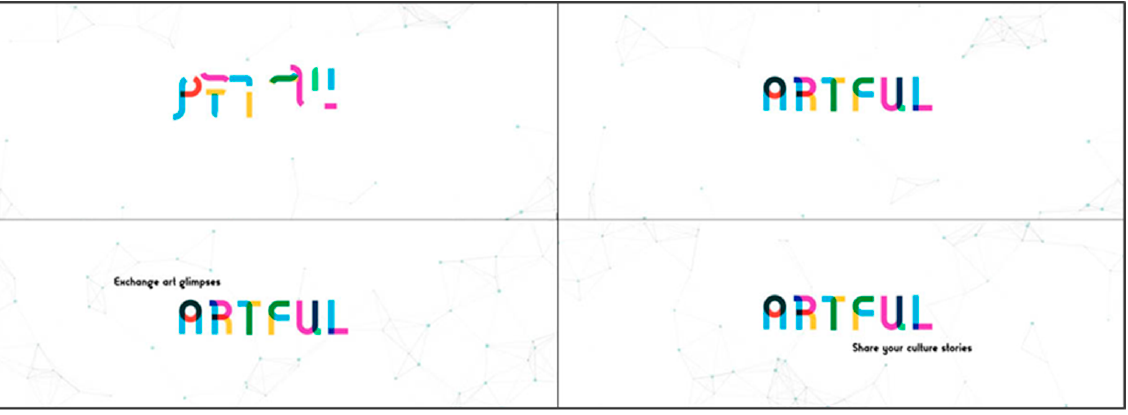
Figure 2. ARtful’s logo presented in the app’s intro video.